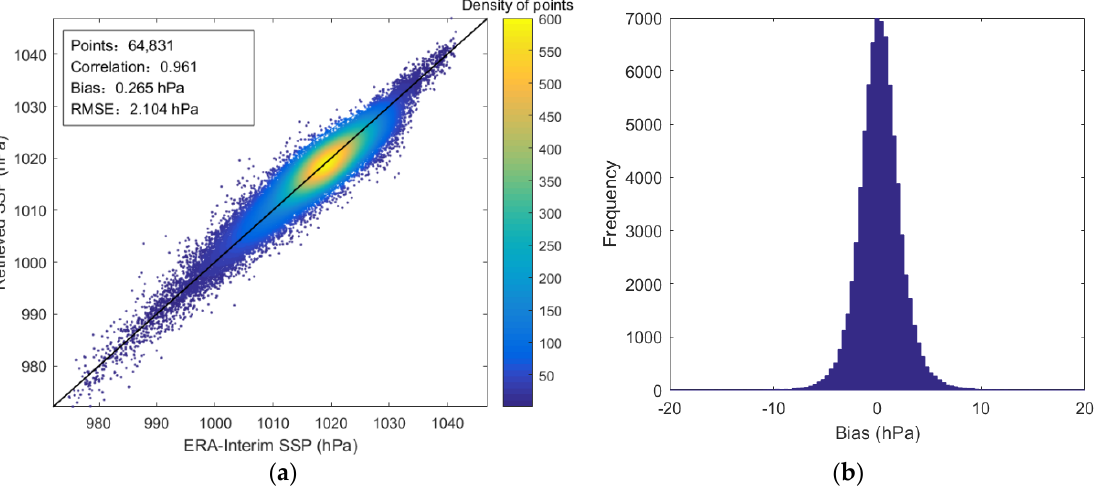
Figure 13. The SSP retrieval result and the distribution of retrieval bias from the optimal theoretical channel combination: ( a ) The retrieval result; ( b ) The distribution of bias.